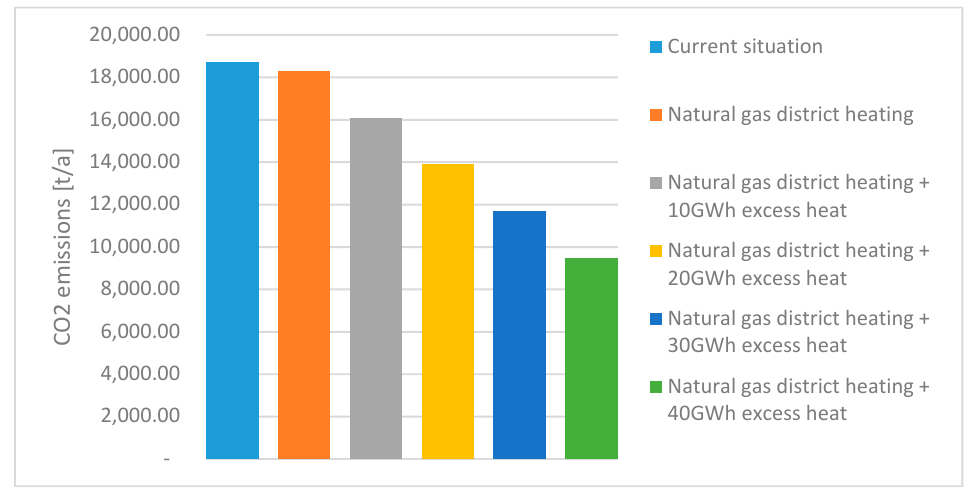
Figure 5. Results of CO 2 emission analysis for different cases. Table 4. NO x , PM, and CO emissions for different